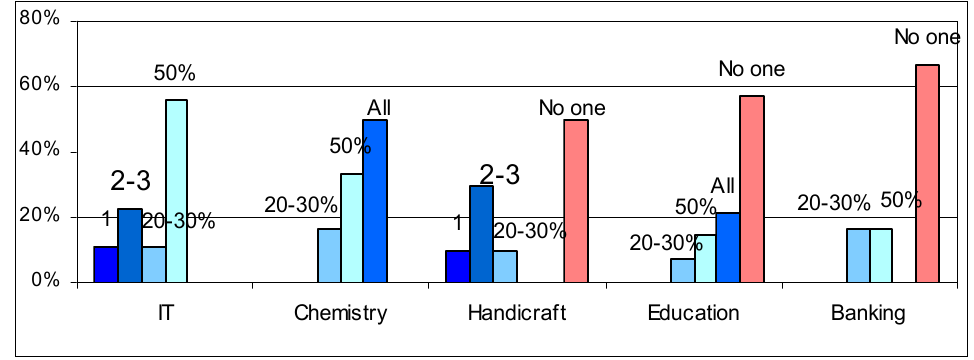
Figure 3. The experts’ opinions on exceptional persons or core staff groups in the business.